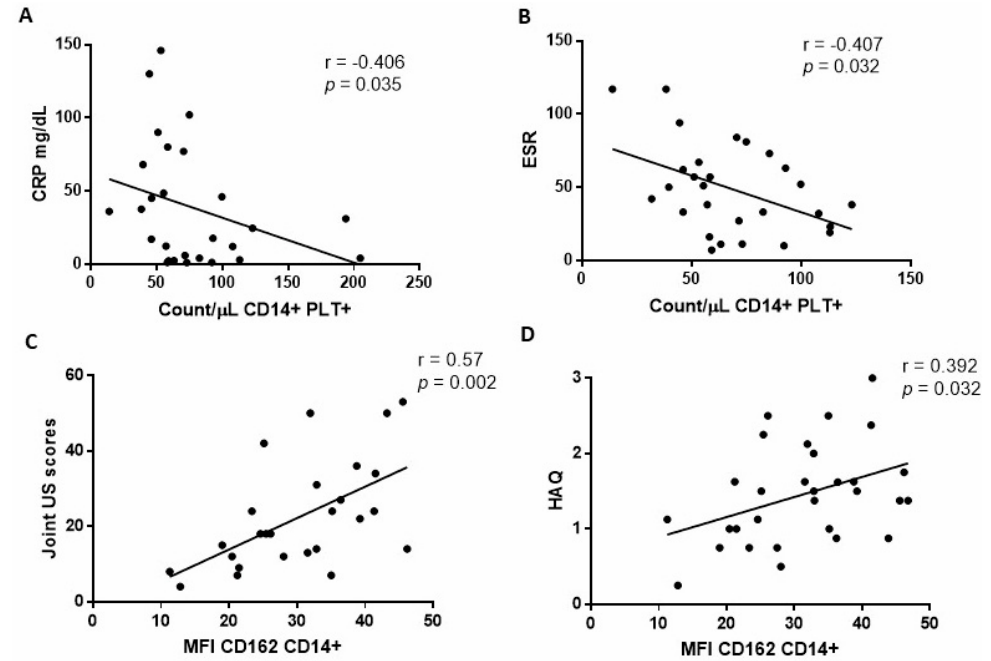
Figure 2. Association of monocytes with bound platelets and CD162 expression on monocytes with baseline clinical and laboratory parameters in rheumatoid arthritis (RA) patients. ( A ) Absolute num- ber of monocytes with bound platelets (CD14+PLT+) correlation with CRP and ( B ) ESR. ( C ) CD162 expression on monocytes correlation with joint ultrasound (US) scores and ( D ) health assessment questionnaire (HAQ). Statistical analysis was performed using Spearman’s